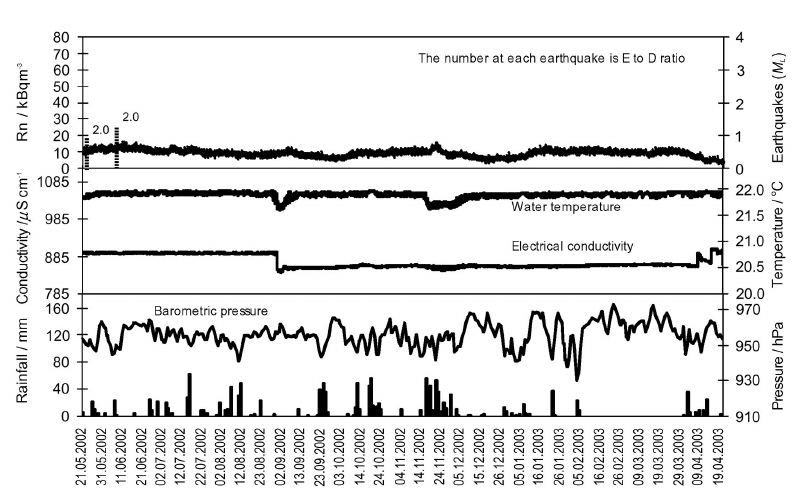
Fig. 7. Geochemical data measured in the thermal spring at Bled between May 2002 and April 2003. The first dia- gram (starting from the top) shows radon concentration (kBqm –3 ) and earthquakes ( M L ). E is the distance between the measuring station and the epicentre, while is D the strain radius. The second diagram shows electrical conductivity ( µ Scm –1 ) and water temperature (°C), and the third diagram shows rainfall (mm) and barometric pressure (hPa).